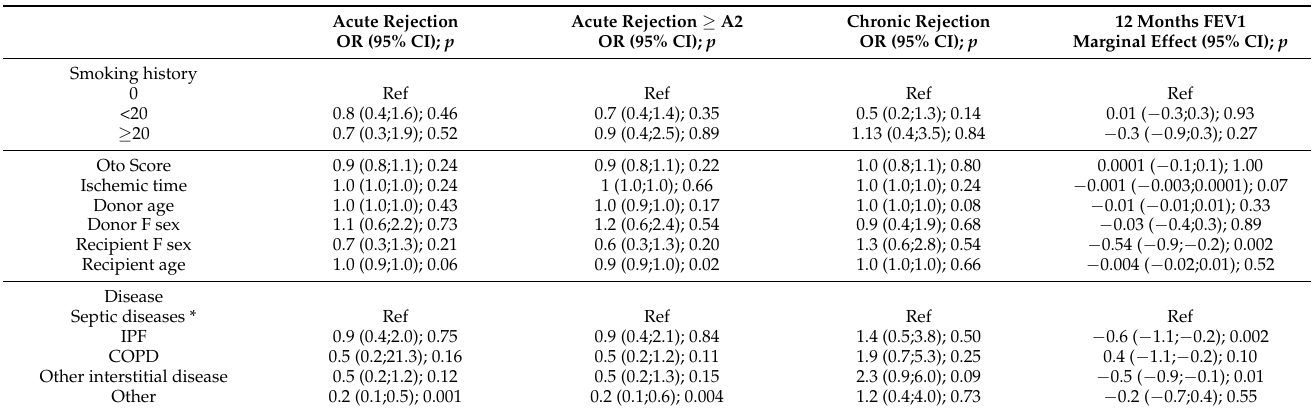
Table 4. Multivariate analysis of variables associated with mid and long-term post-transplant outcomes 1 .